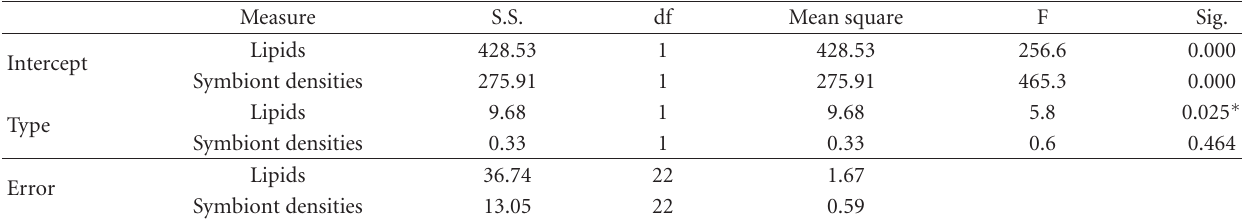
Table 1: The results of a multivariate repeated measure ANOVA showing the significant between-subject e ff ect of type (C2 or D) on lipid stores of Acropora millepora colonies before a bleaching. ∗ indicate significant